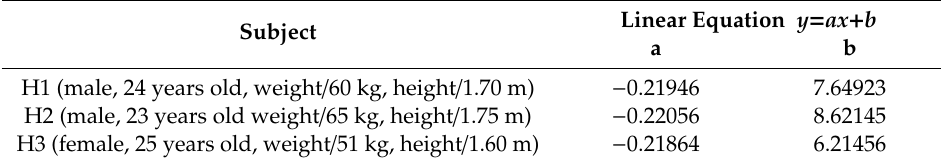
Figure 10. The relationship between the angular displacement of the knee joint and standard interaction torque in the knee joint. Table 3. Results of the human-exoskeleton interaction measurement experiment.